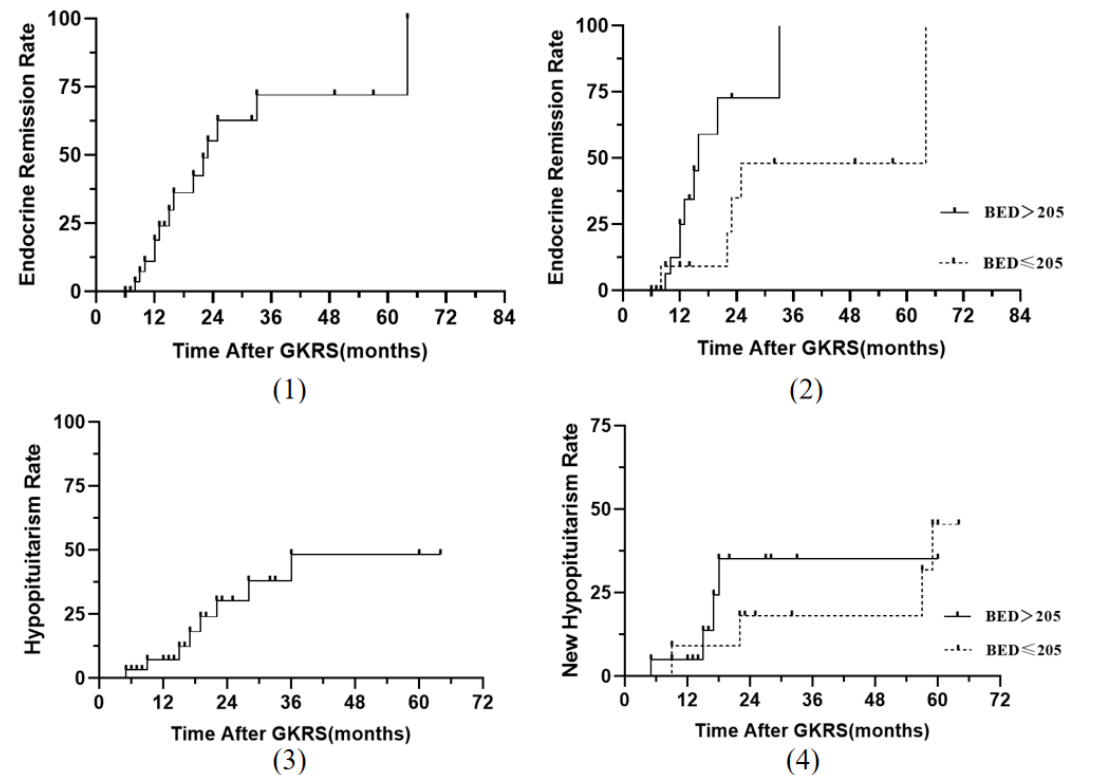
Figure 1. The trend of the 24 UFC ( 1 ) and cortisol after 1 mg DST ( 2 ) for patients with Cushing’s disease after receiving GKRS.